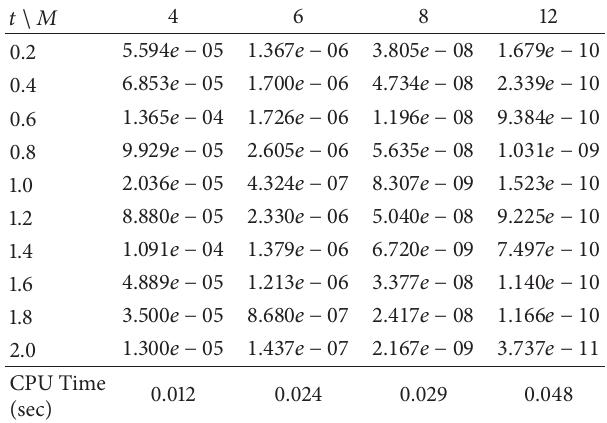
Table 2: Maximum errors 𝐸 𝑁 for Burgers-Fisher’s equation when 𝛼 = 𝛽 = 1 and ℎ = −0.9 .